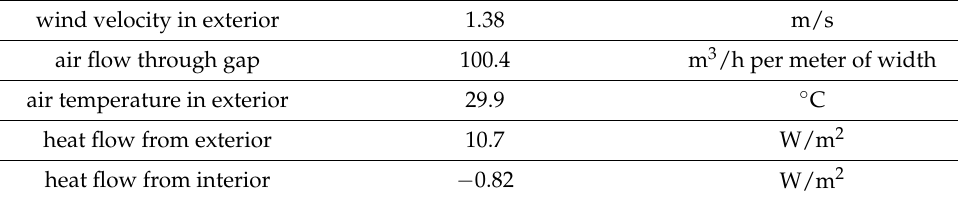
Table 1. Boundary conditions of summer extreme in July 2022.